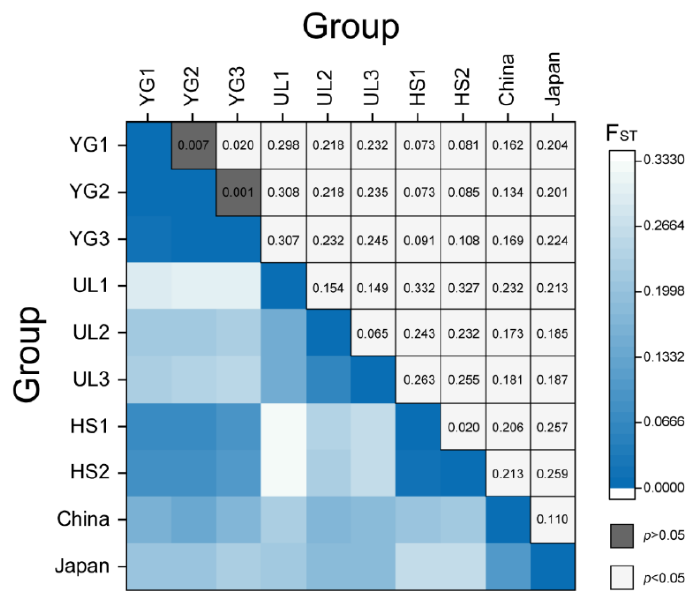
Figure 3. A heatmap showing paired F ST values among spring orchids from Yeonggwang-gun (YG), Ulleung Island (UL), Heuksan Island (HS), China, and Japan. The numbers in the box represent paired F ST values between groups. Dark colored boxes with F ST values indicate that the F ST value is not significant ( p > 0.05), whereas light colored boxes with F ST values indicate that the F ST value is significant ( p < 0.05).